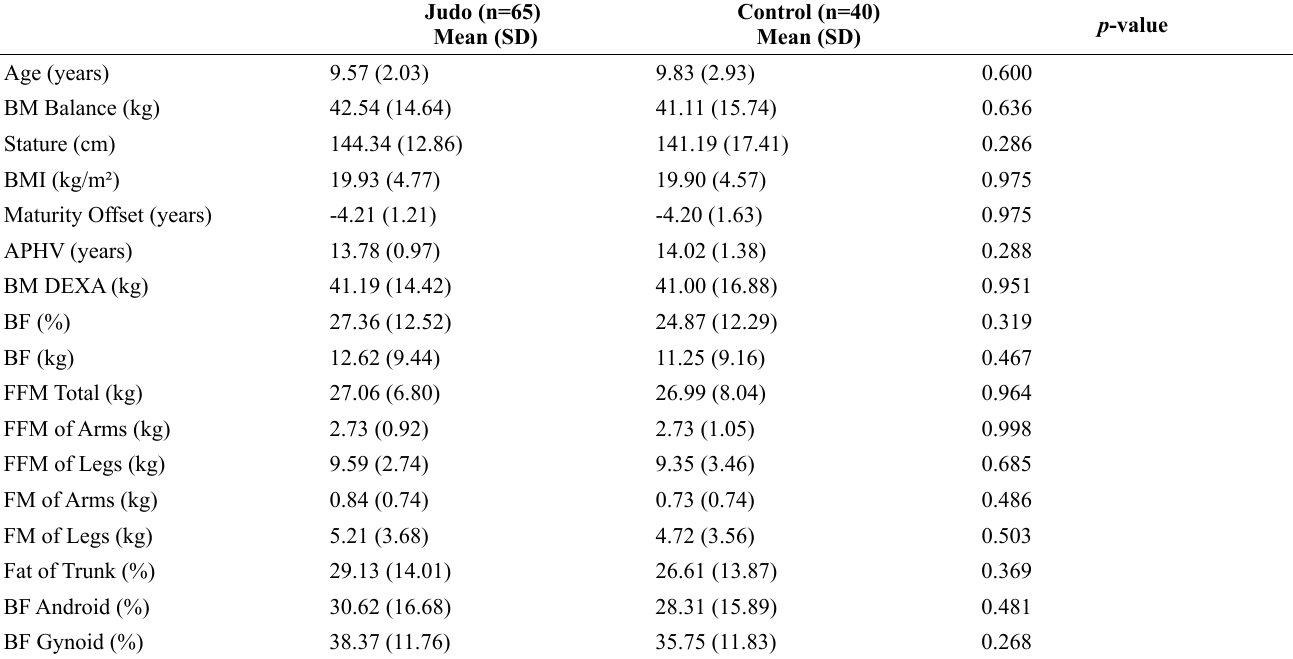
Table 1. Description of the sample.